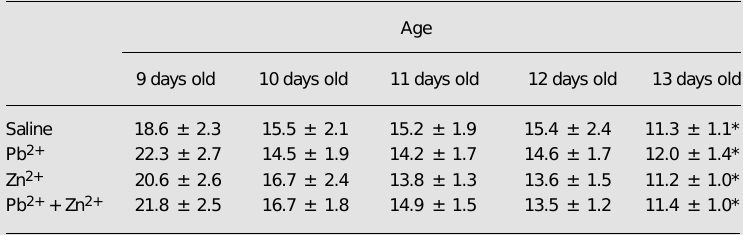
Table 2. Effect of lead acetate and/or zinc chloride administration on the latency to complete a geotaxis response.